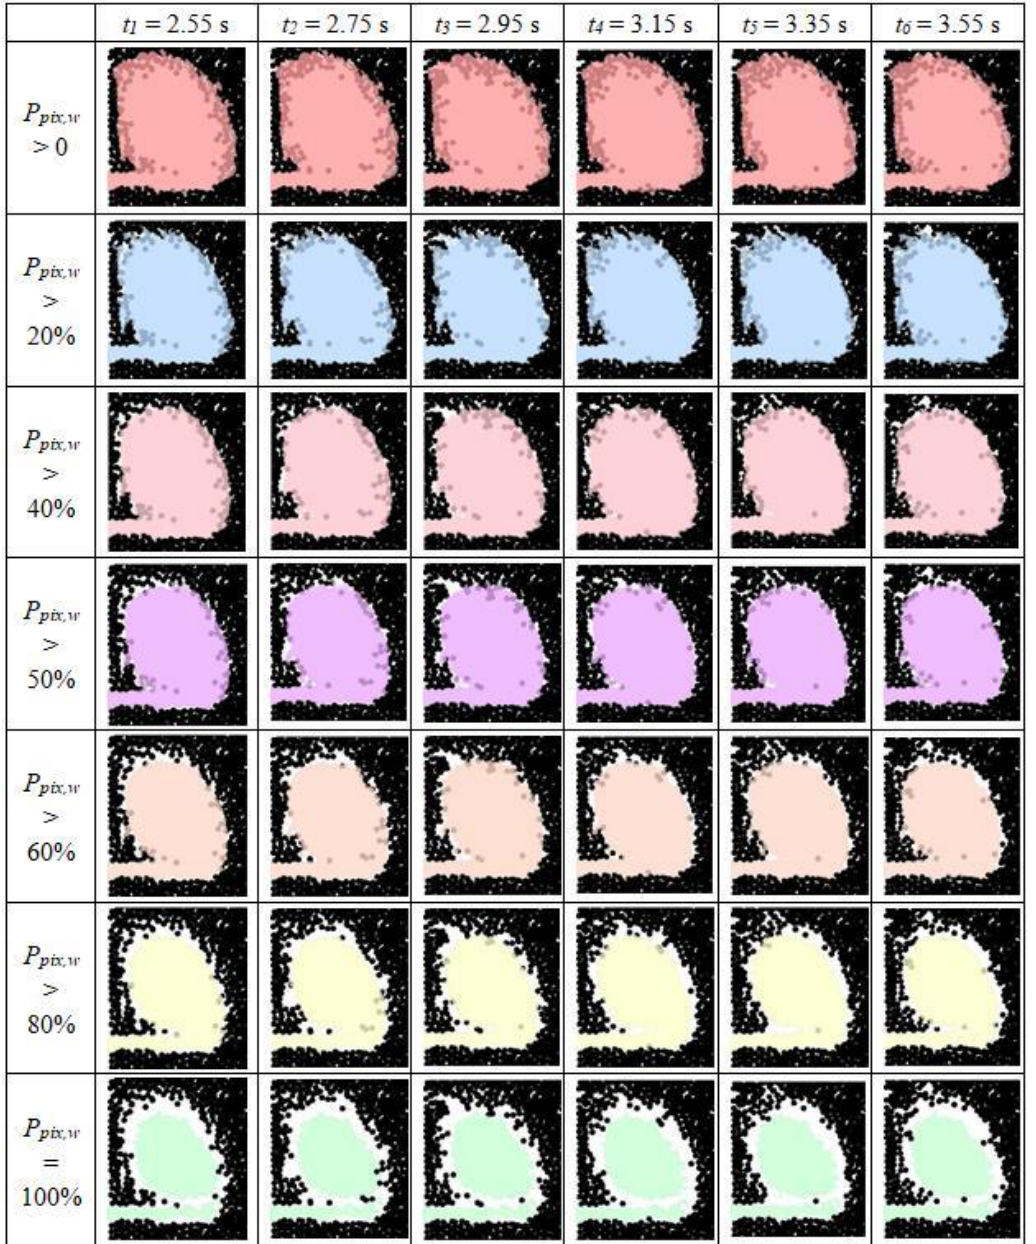
Figure A3. The comparisons between the binary image of the void when t = 2.55 s, 2.75 s, 2.95 s, 3.15 s, 3.35 s, and 3.55 s and the images of which P pix,w > 0%, P pix,w > 20%, P pix,w > 40%, P pix,w > 50%, P pix,w > 60%, P pix,w > 80% and P pix,w = 100%, respectively.